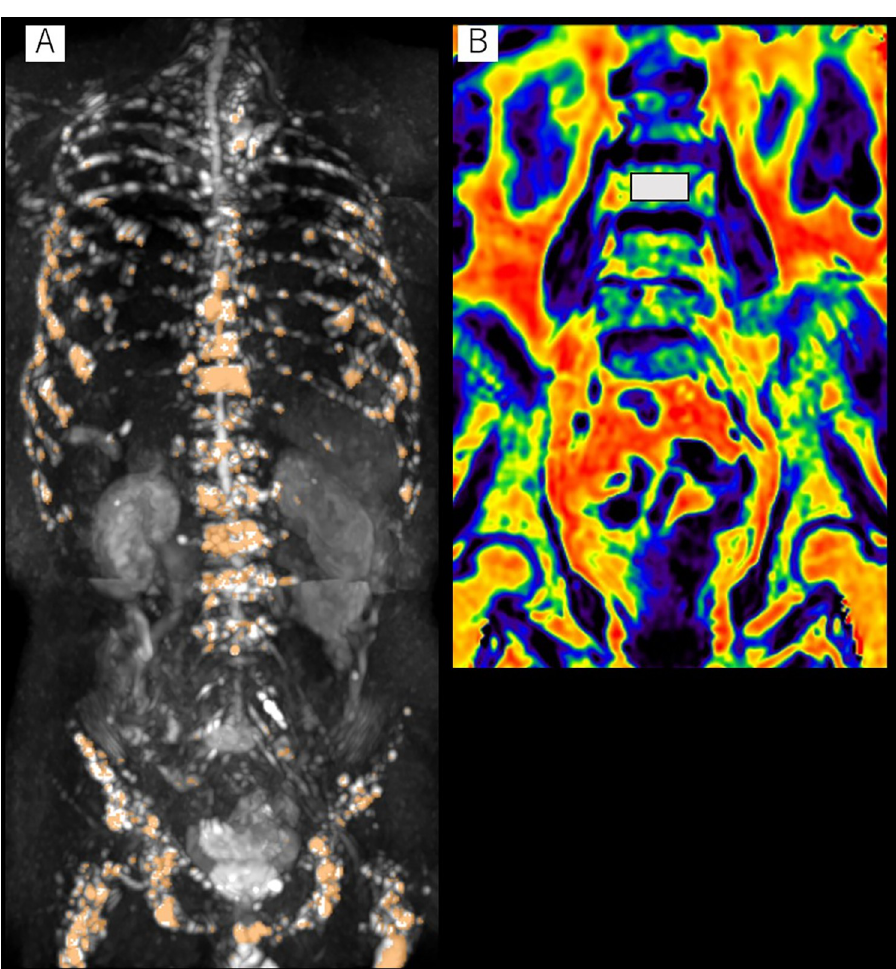
Fig 1. Semi-automated segmentation of myeloma lesions and measurement of fat fraction on MR images. (A) Coronal maximum intensity projection image acquired by diffusion-weighted imaging with a computed b-value of 1000 s/mm 2 . For estimation of whole-body volumetric tumor burden by measurement of apparent diffusion coefficient (ADC), voxels showing an ADC between 0.55 × 10 − 3 and 2.0 × 10 − 3 mm 2 /s are extracted (indicated in orange) as an estimate of total diffusion volume, as a surrogate marker for tumor burden. (B) Coronal fat fraction map obtained by modified Dixon Quant sequence. The region of interest (white rectangle) for measuring fat fraction is placed on the L3 vertebral body on a midcoronal image. The region of interest cannot be placed from L1 to L3 on a single image because the mid-coronal level of each vertebral body is different due to lumbar lordosis.